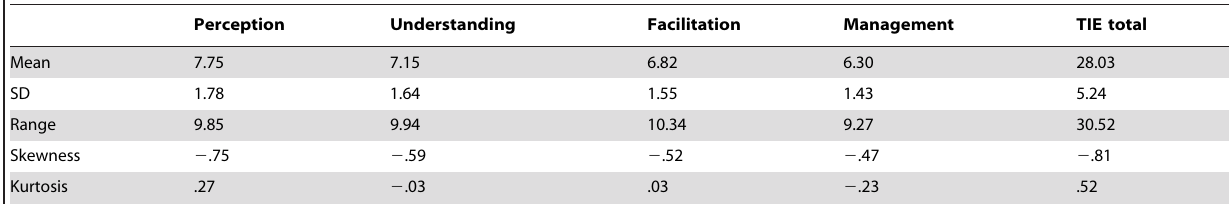
Table 1. Descriptive statistics.